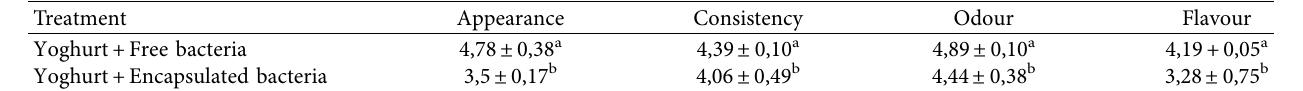
Table 9: Sensory evaluation scores (mean ± SD) of yoghurts.